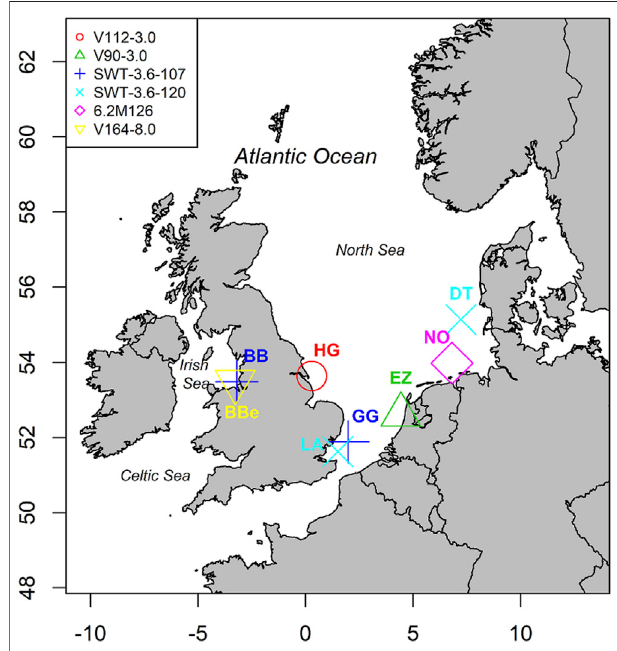
FIGURE 1 | Study area and map of the analyzed offshore wind farms. Legend indicates the turbine models for each wind